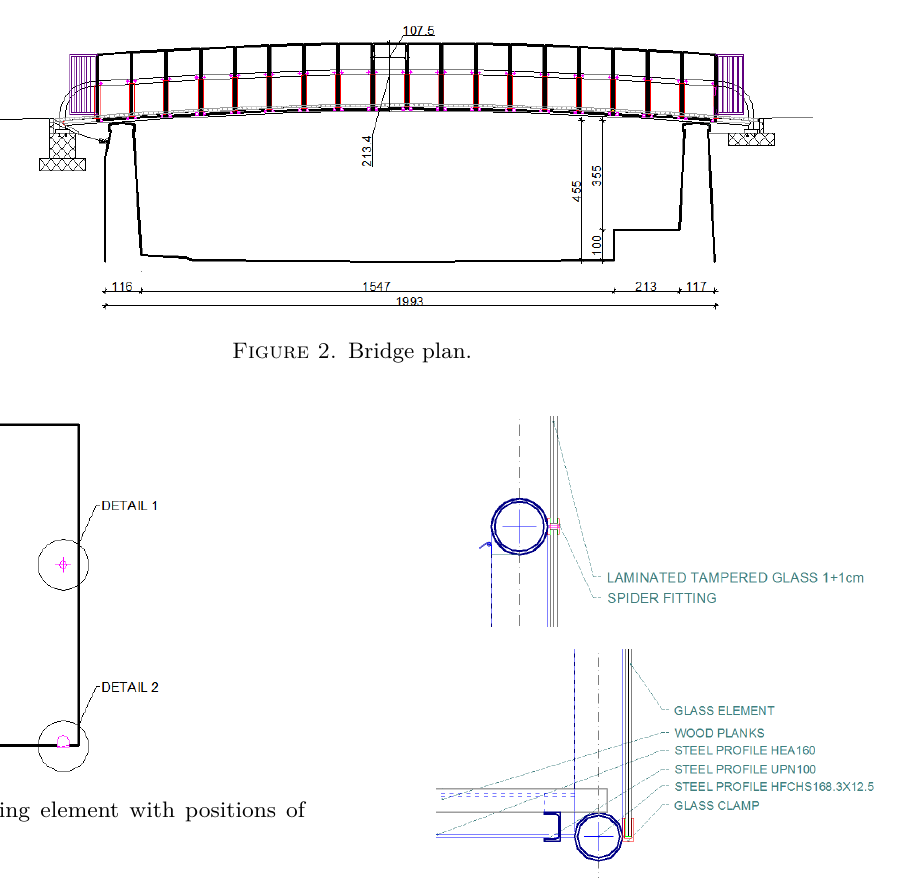
Figure 4. DETAIL 1: spider fitting (up), DETAIL 2: inox clamps connecting the element to the main steel profile